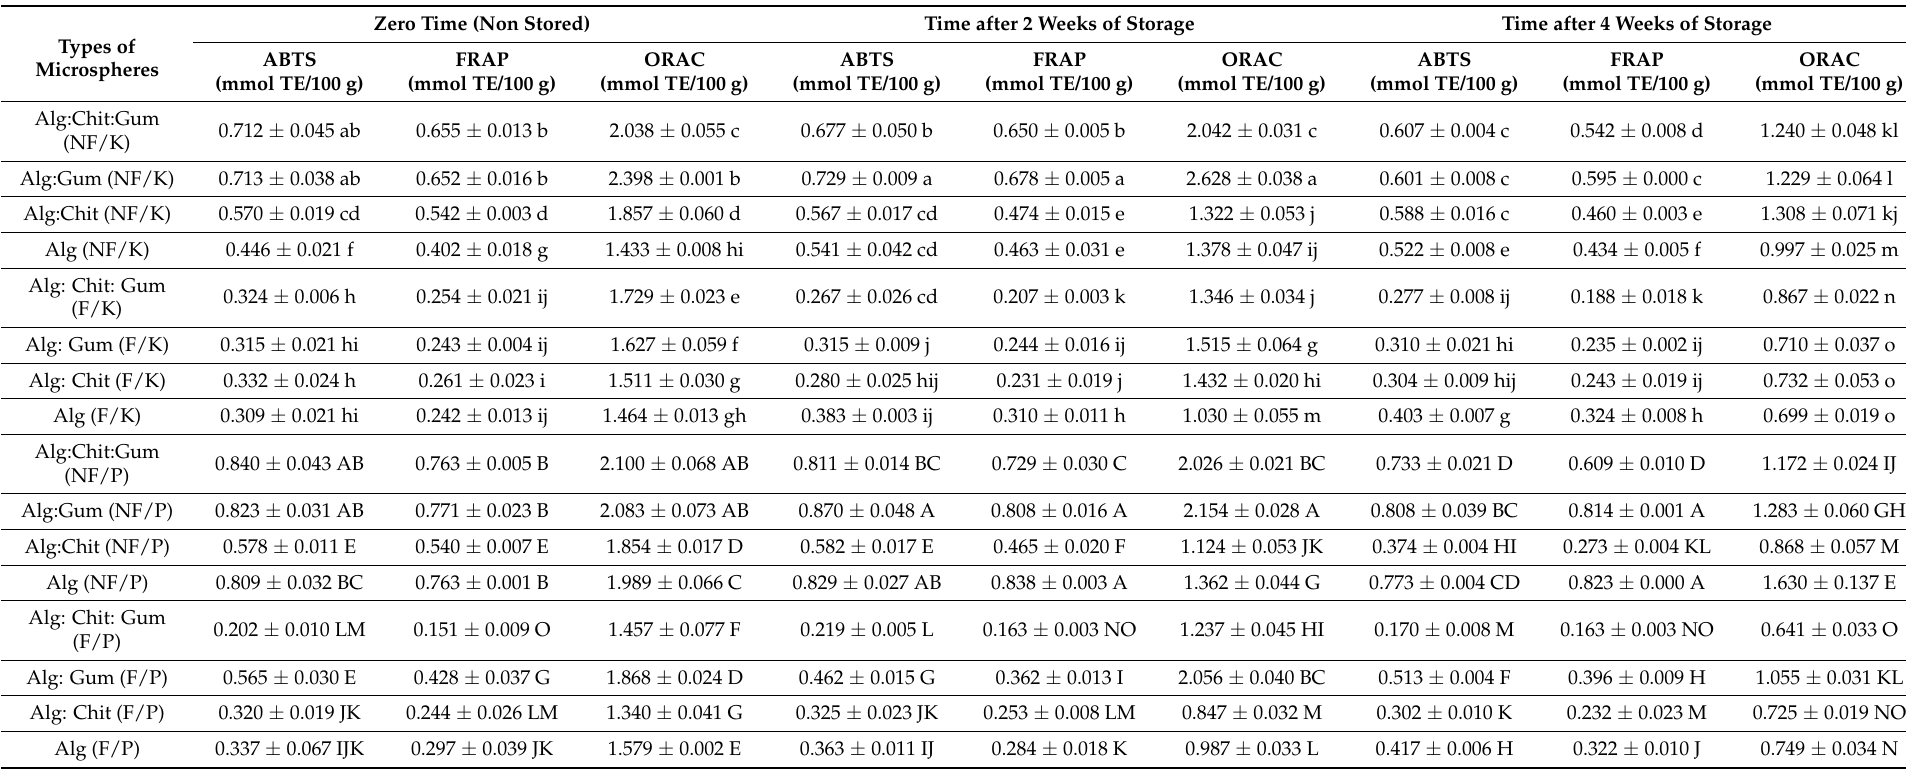
Table 3. Antioxidant activity (mmol TE/100 g) of microspheres with chokeberry concentrate and chokeberry